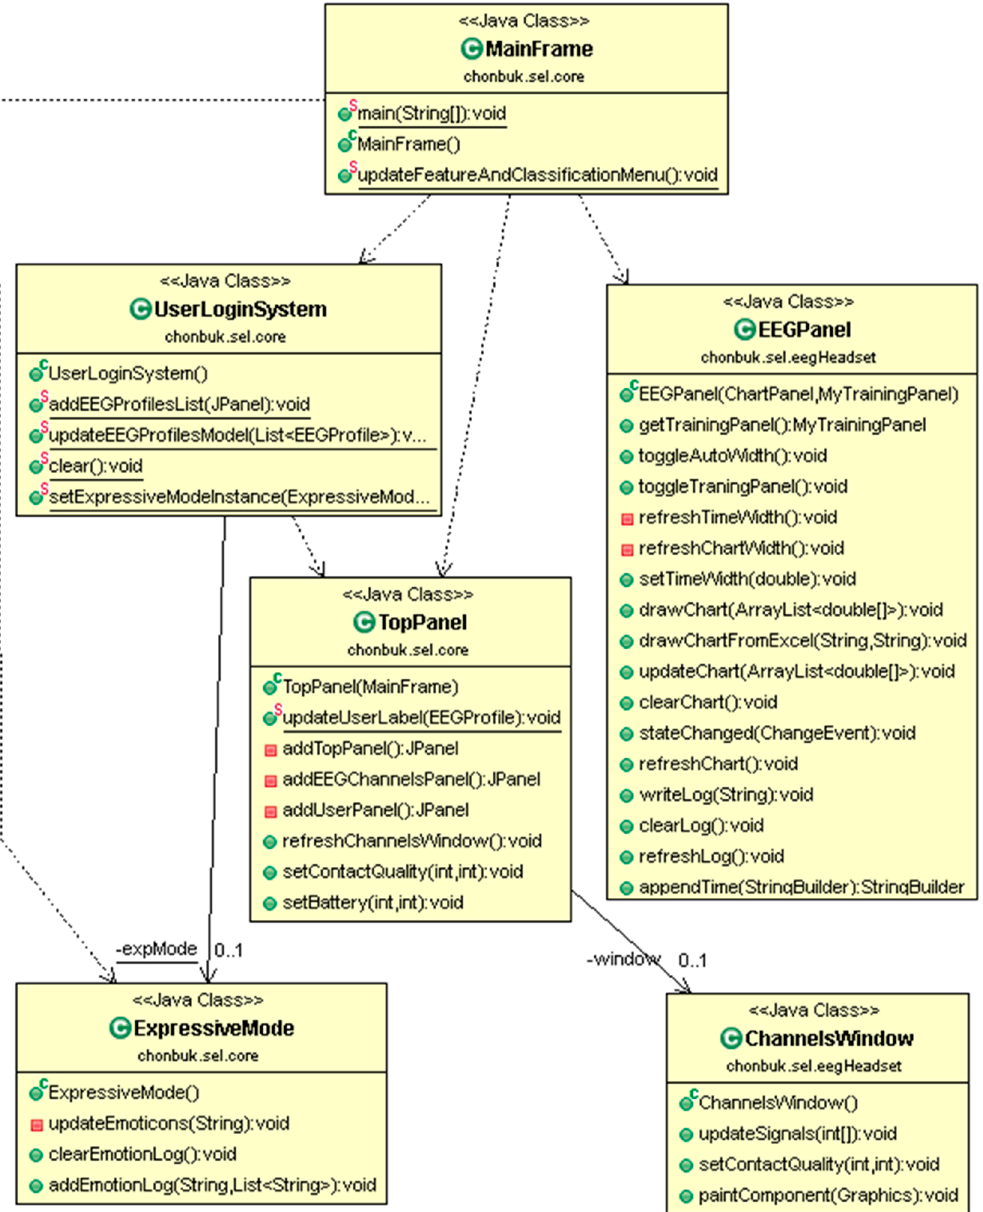
Figure 4. Class diagram representing the main graphical user interfaces of system.